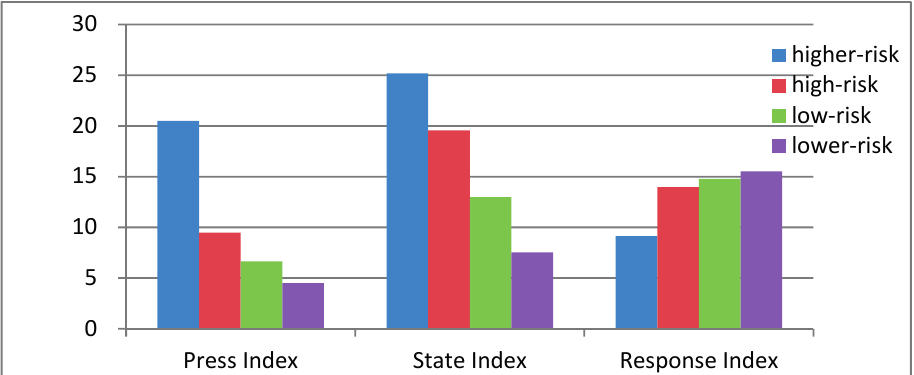
Figure 2. Average risk indexes for four type